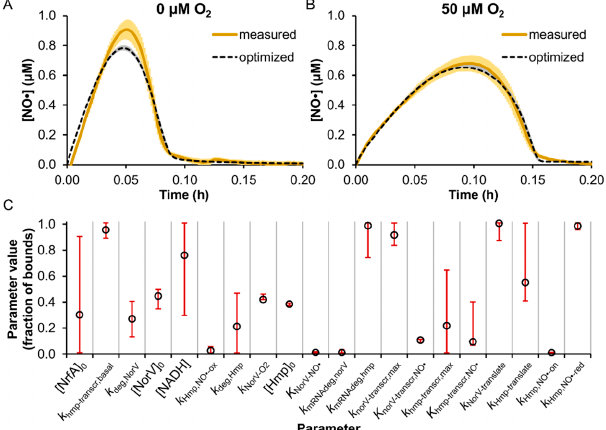
Figure 2. Model training on [NO ¨ ] measurements in enterohemorrhagic Escherichia coli (EHEC) cultures at 0 and 50 µ M O 2 . TUV hmp + / norV + were treated with 50 µ M DPTA NONOate at an OD 600 of 0.05 under conditions of ( A ) 0 µ M O 2 or ( B ) 50 µ M O 2 , and the resulting [NO ¨ ] was measured (solid yellow line; mean of 3 independent experiments, with light yellow shading representing the SEM). Simulated [NO ¨ ] curves for each condition are shown (dashed black lines), and were obtained using the best-fit parameter set from the model training process, where gray shading represents the range of simulated [NO ¨ ] curves from the ensemble of viable parameter sets (ER < 10). ( C ) Parameter values (expressed as a fraction of the allowed bounds) obtained from the MCMC analysis are shown, where open circles are the best-fit parameter set (ER = 1), and error bars represent the viable range (min and max) that maintained an ER < 10. Descriptions of parameter names can be found in Table